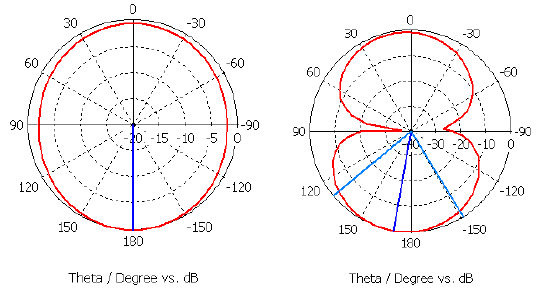
Figure 12. E and H plane radiation pattern at 4.75 GHz.